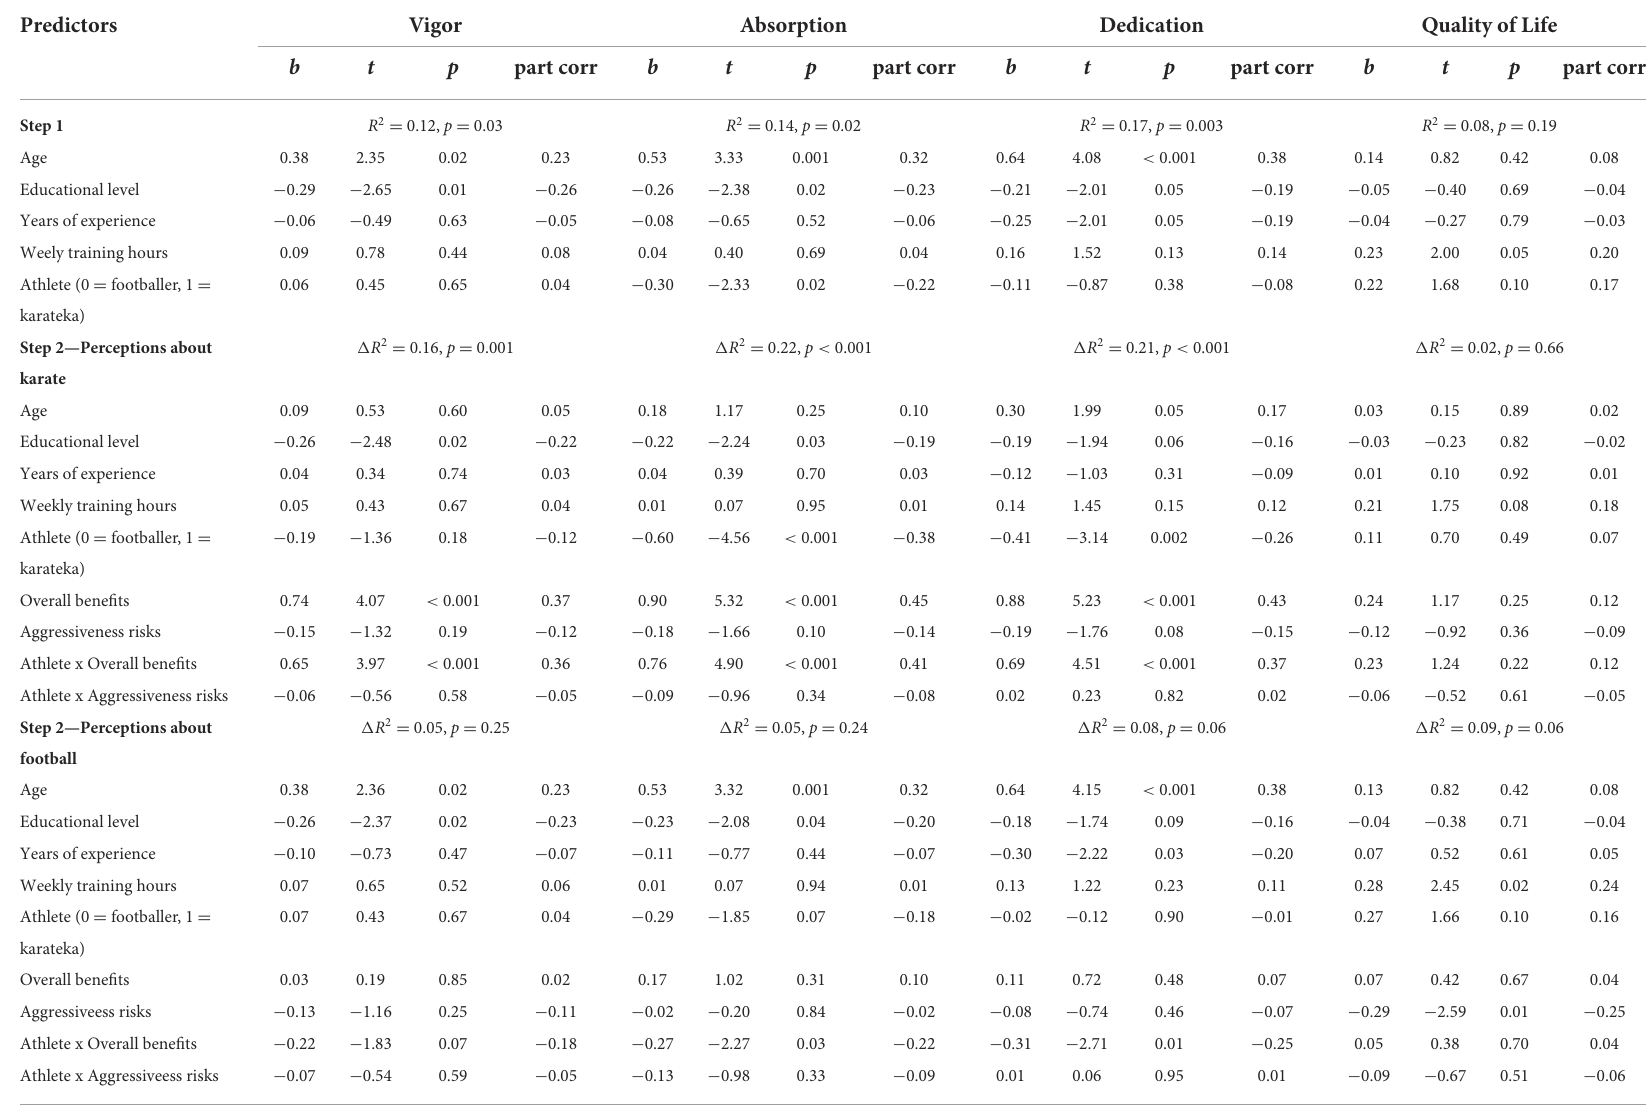
TABLE 4 Complete results of all regression models